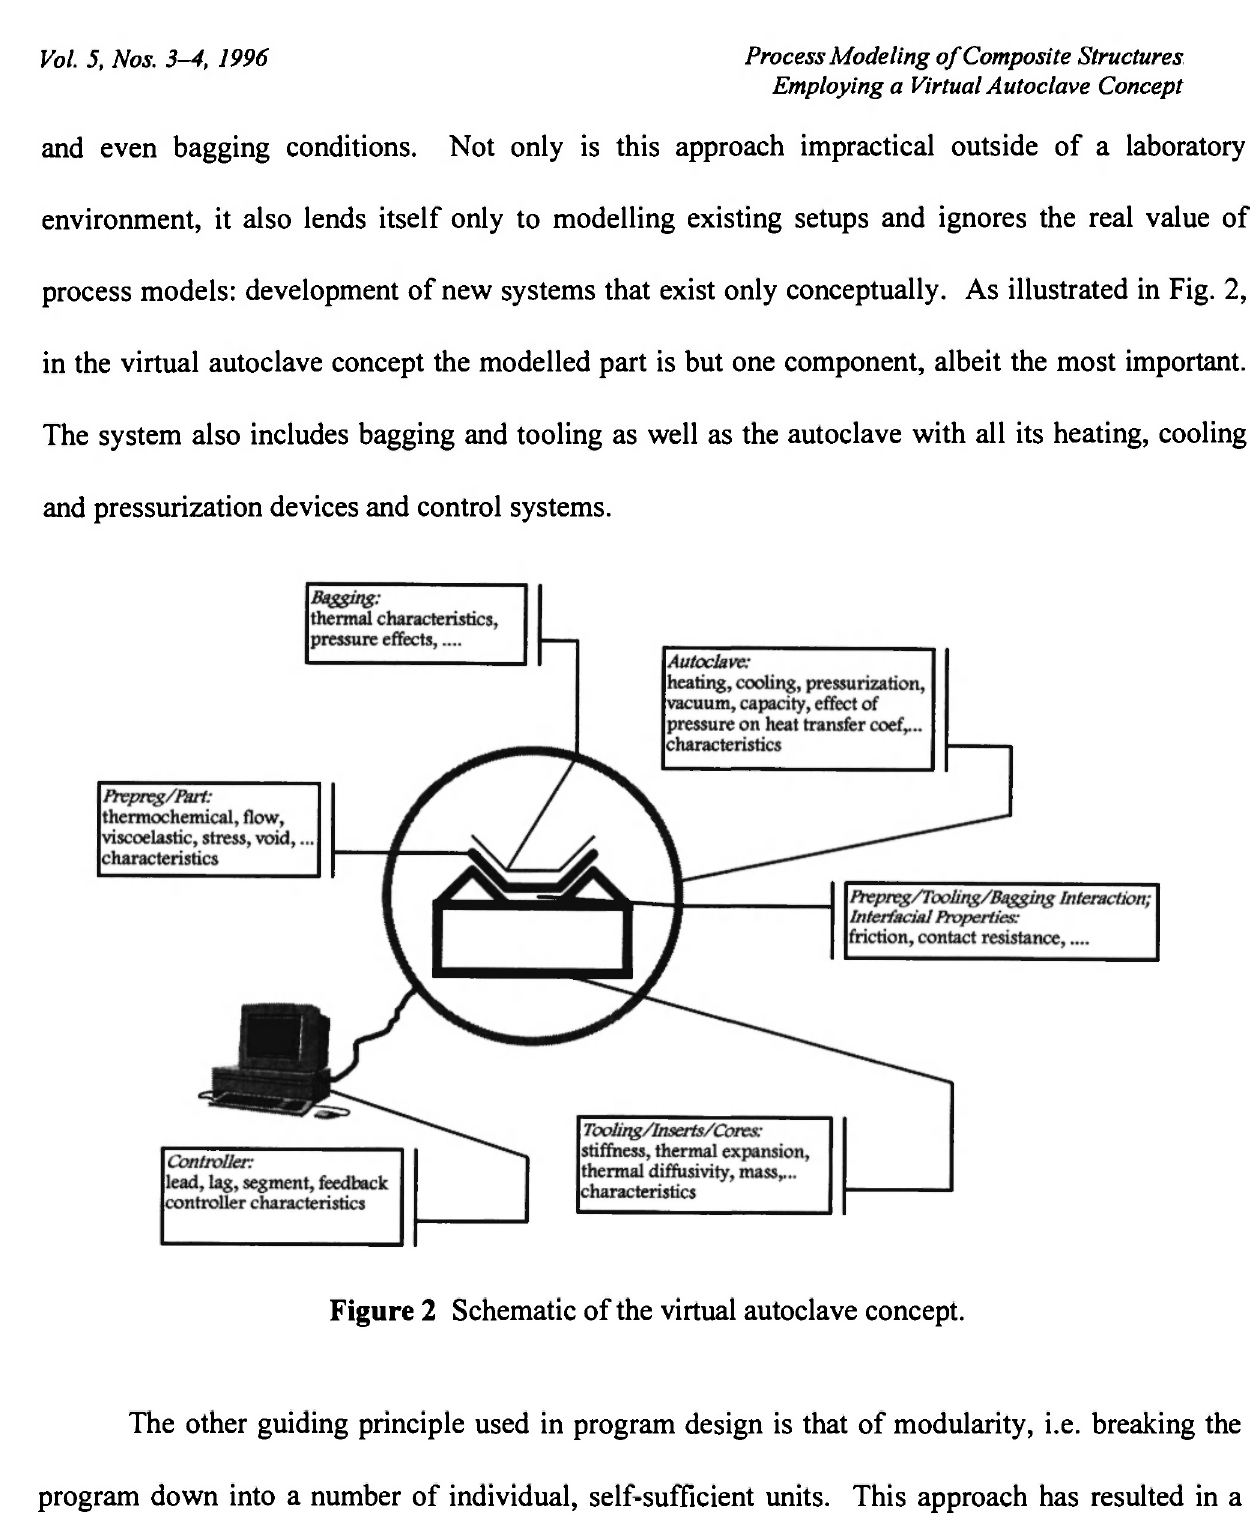
Figure 2 Schematic of the virtual autoclave